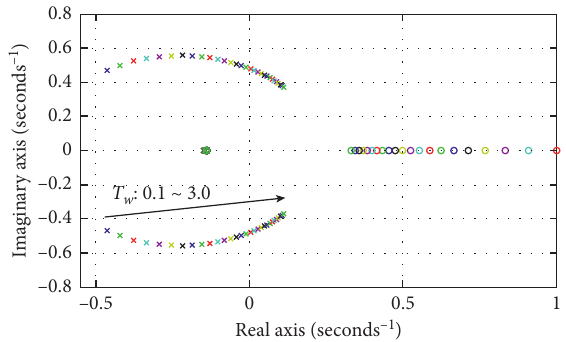
Figure 8: Zero-pole variation of the closed-loop transfer function of the rotational speed closed-loop when the water flow inertia time constant T w